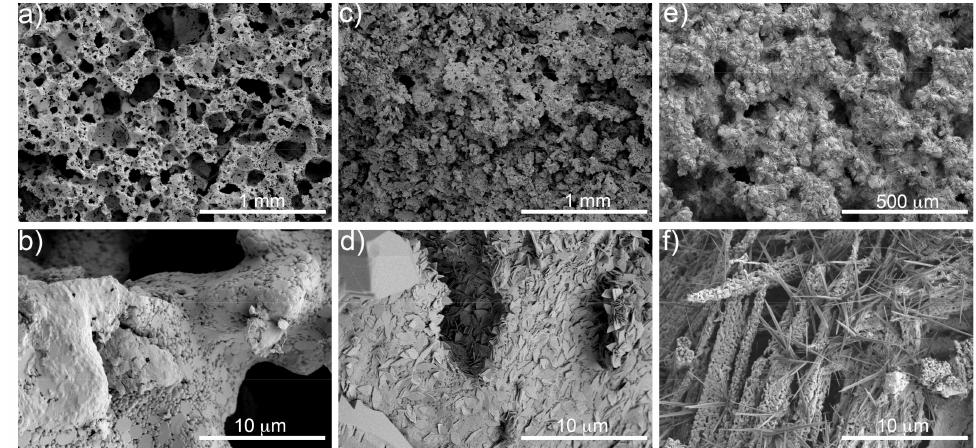
Figure 4. SEM micrographs at di ff erent magnifications of the unaged foam ( a , b ) and of foams aged 1 ( c , d ) and 8 weeks ( e , f